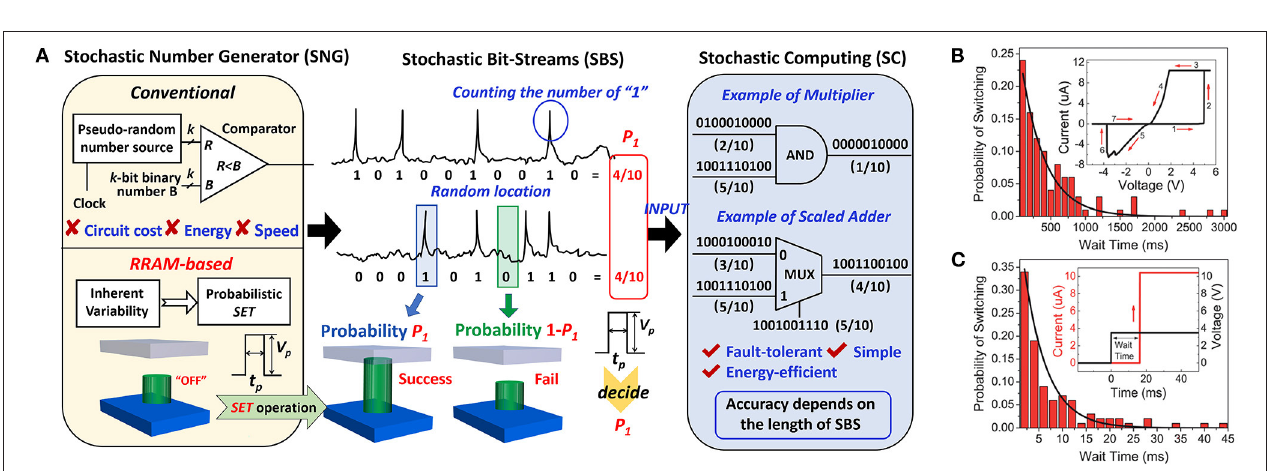
FIGURE 9 | (A) The schematic of the RRAM-based stochastic number generator (SNG) in the stochastic computing (SC) system. The RRAM-based SNG utilizes the probabilistic SET to randomly generate “1” or “0.” (B) The SET waiting time distribution when the pulse amplitude is 2.5V and (C) 3.5V. Reprinted from Knag et al. (2014) and Zhao et al.